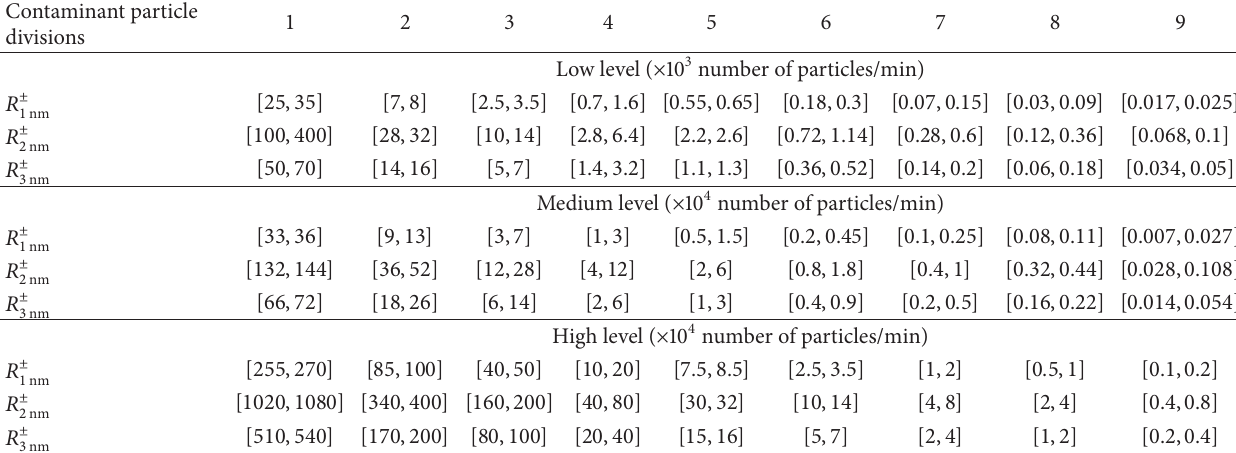
Table 5: Initial contaminant ingression/generation rates of hydraulic